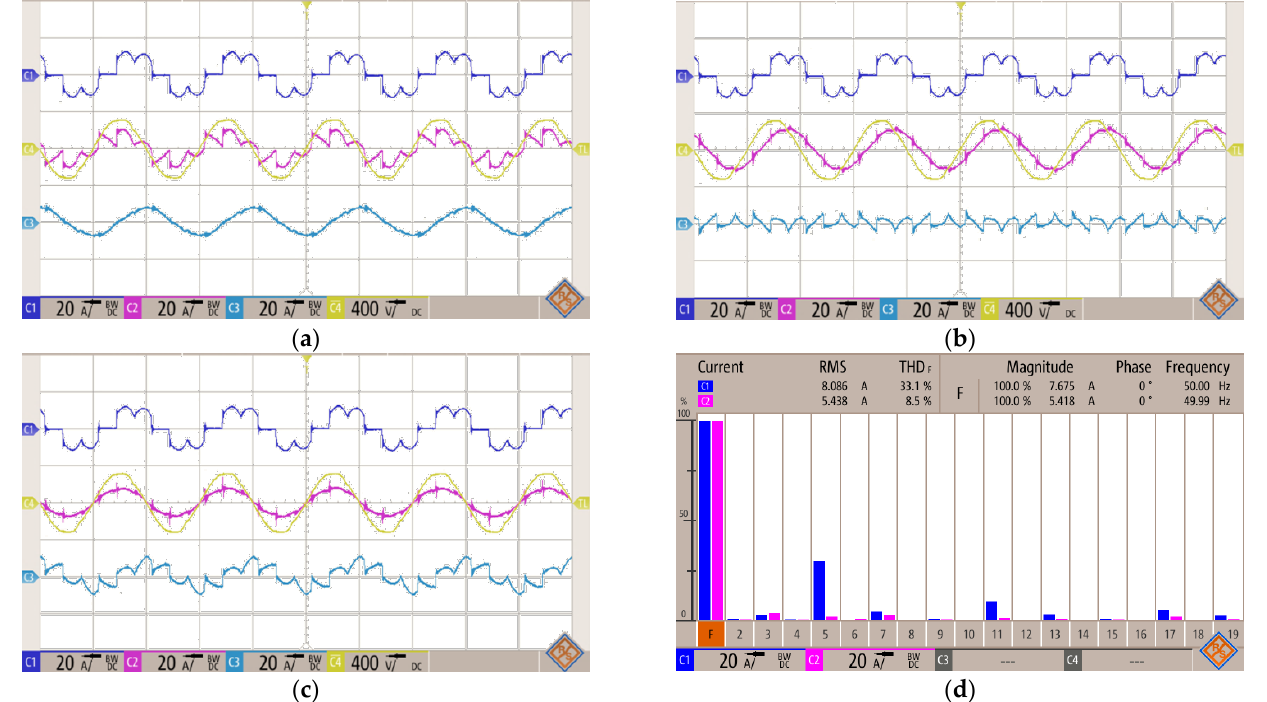
Figure 13. Operation of NPC T-type APF in different operation modes (with thyristor rectifier supplying DC motor as a load): ( a ) Operation in reactive power compensation mode; ( b ) Operation in current harmonics reduction mode; ( c ) Operation in simultaneous reactive power compensation and current harmonics mode; ( d ) Harmonic spectra of load and grid currents for simultaneous operation mode.